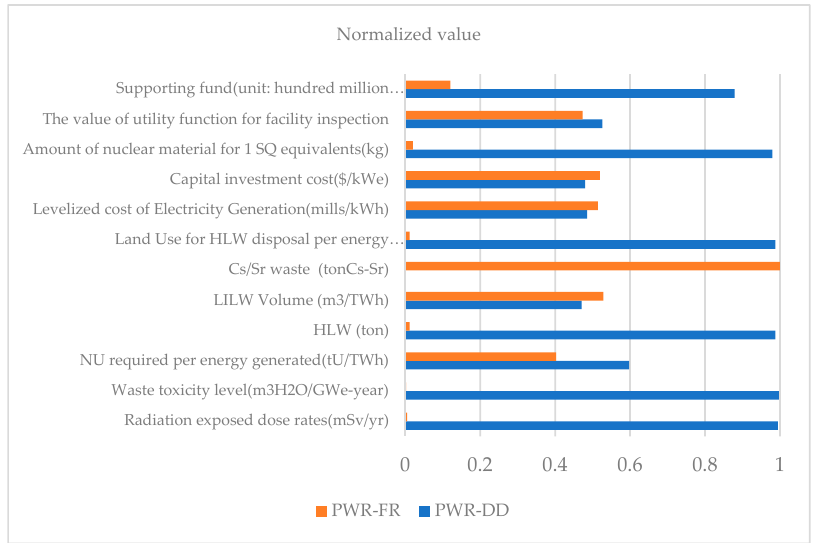
Figure 7. Evaluation index for PROMETHEE method.